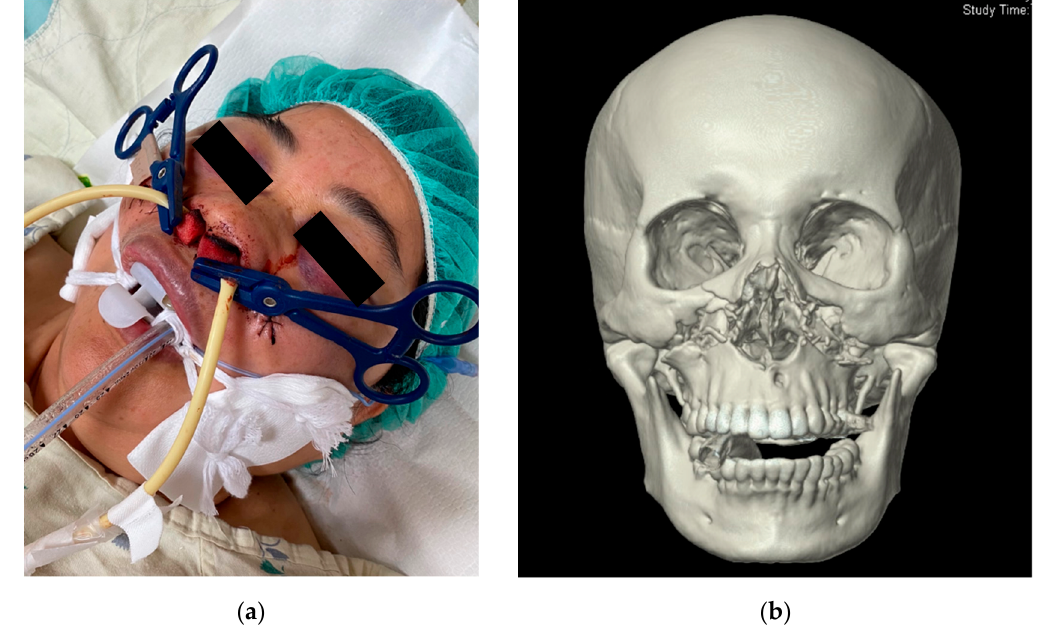
Figure 2. A 55-year-old female who presented with massive oronasal bleeding after facial trauma. ( a ) Patient was intubated for airway protection. Arterial and posterior nasal packing was performed after intubation. ( b ) CT scan shows bilateral maxillary